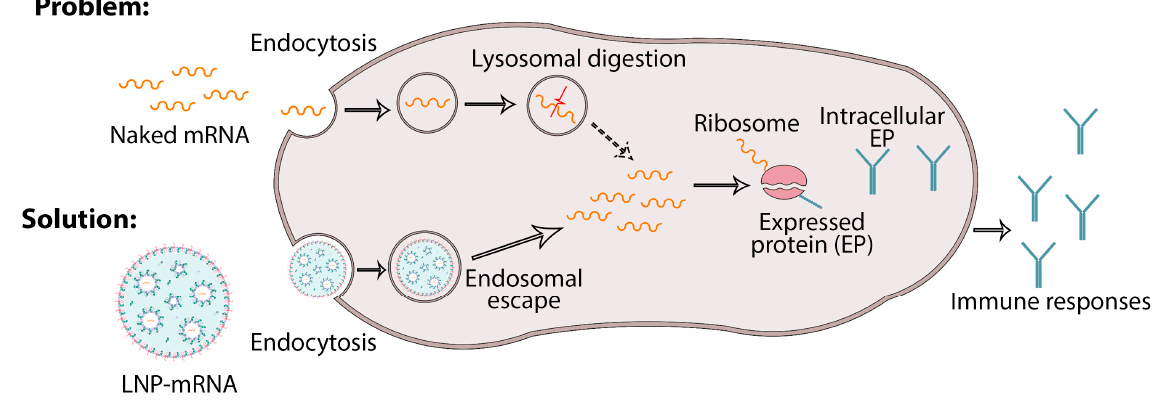
Figure 5. Adsorption of mRNA loaded in lipid nanoparticles into the host cells, which is a solution to prevent the degradation of naked mRNA in lysosomes. mRNA-loaded LNPs therefore undergo endosome escape and release mRNA for protein synthesis.